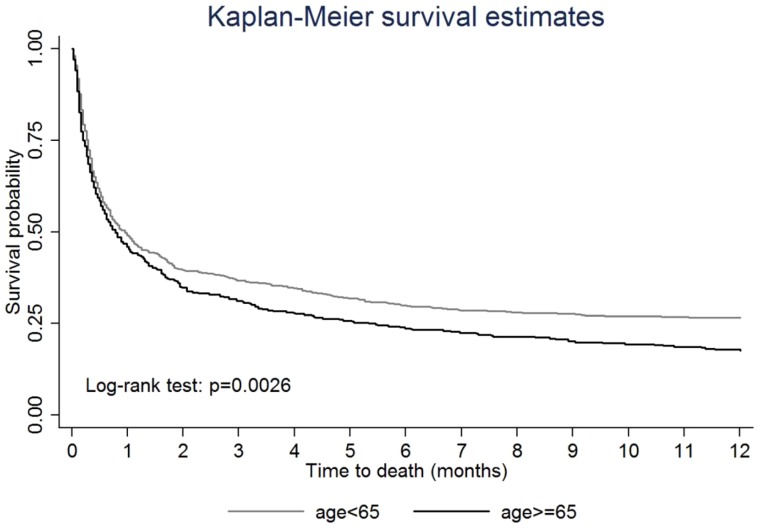
Kaplan-Meier survival curves for mortality of TBI patients with pre-existing ESRD, stratified by age.